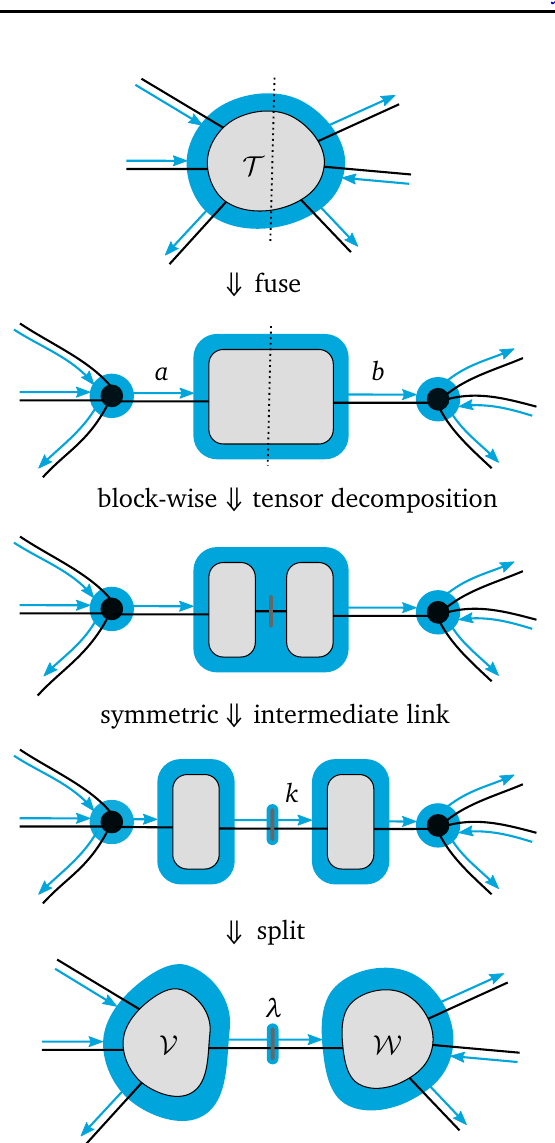
Figure 23: Steps in symmetric tensor decomposition (e.g. QR or singular value decomposition), from top to bottom: First the input tensor T is fused into a matrix over the indicated link bipartition a , b . The resulting degeneracy tensors form a block-wise matrix and can be decomposed independently, often at greatly reduced computational cost. Their factors are separated into two symmetric tensors V and W , connected through a new intermediate symmetric link k , and weighted by singular values λ in the case of an SVD. Finally, the original links are restored with the help of fuse-nodes that were obtained in the initial